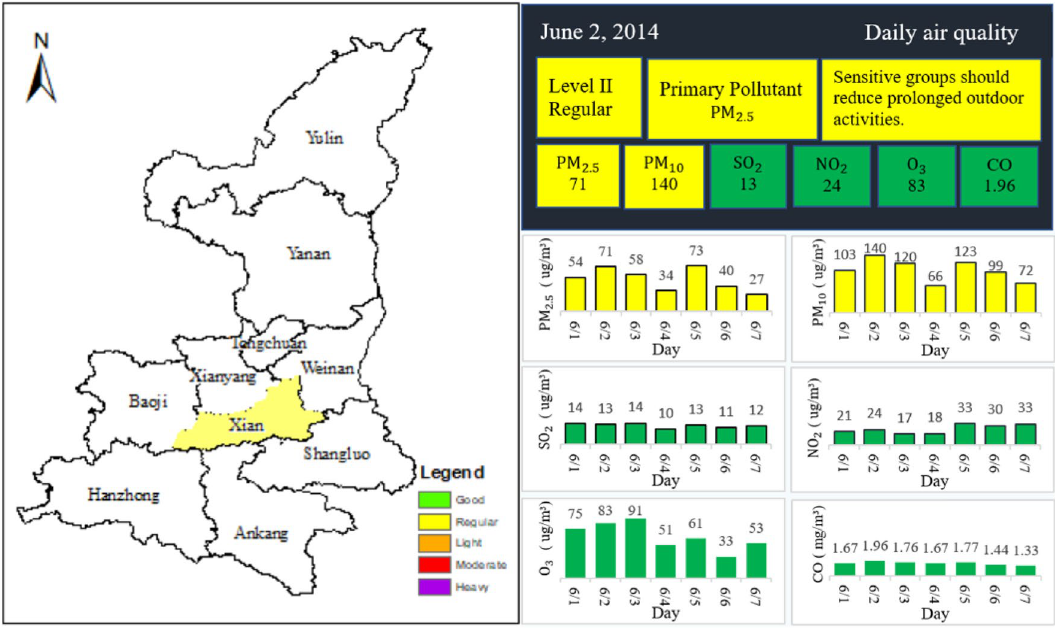
Figure 2. Air quality in Xi’an on June 2, 2014. A map of the Shaanxi province of China. (Generated by ArcGIS 10.8, URL: http:// www. esri. com/ softw are/ arcgis/ arcgis- for- deskt